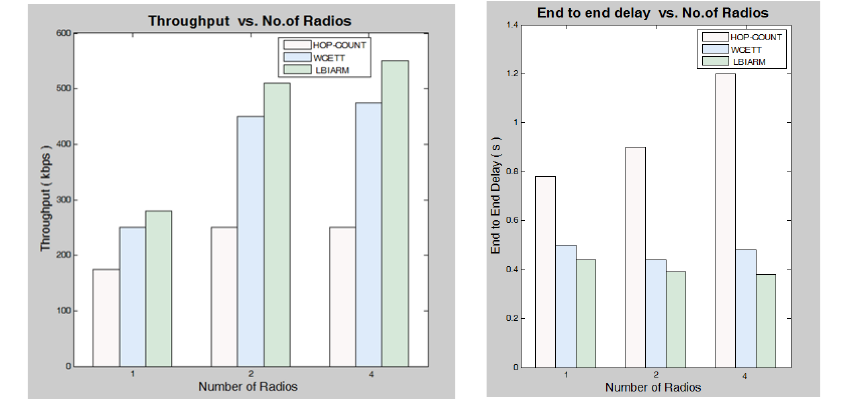
Fig 2 . Throughput versus Radios Fig 3. End to end delay versus radios